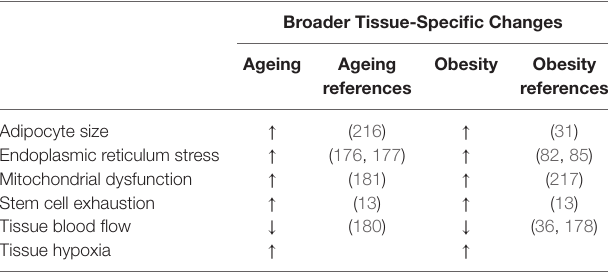
TABLe 5 | Changes in the soluble factors produced and/or released by adipose tissue (adipocytes and cells of the stromal fraction) with age and obesity compared to young and lean, respectively.